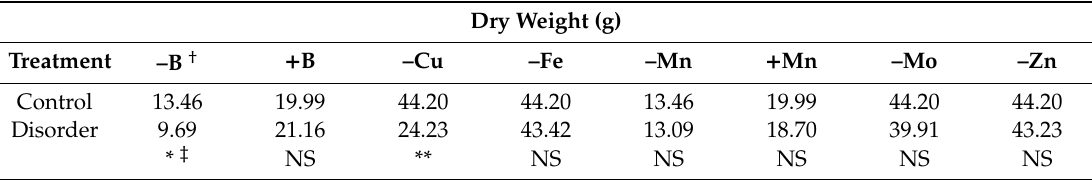
Table 3. Mean dry weights of Cannabis sativa ‘T1’ plants grown with a deficient or toxic micronutrient treatment compared to plants grown with a complete fertilizer regime.